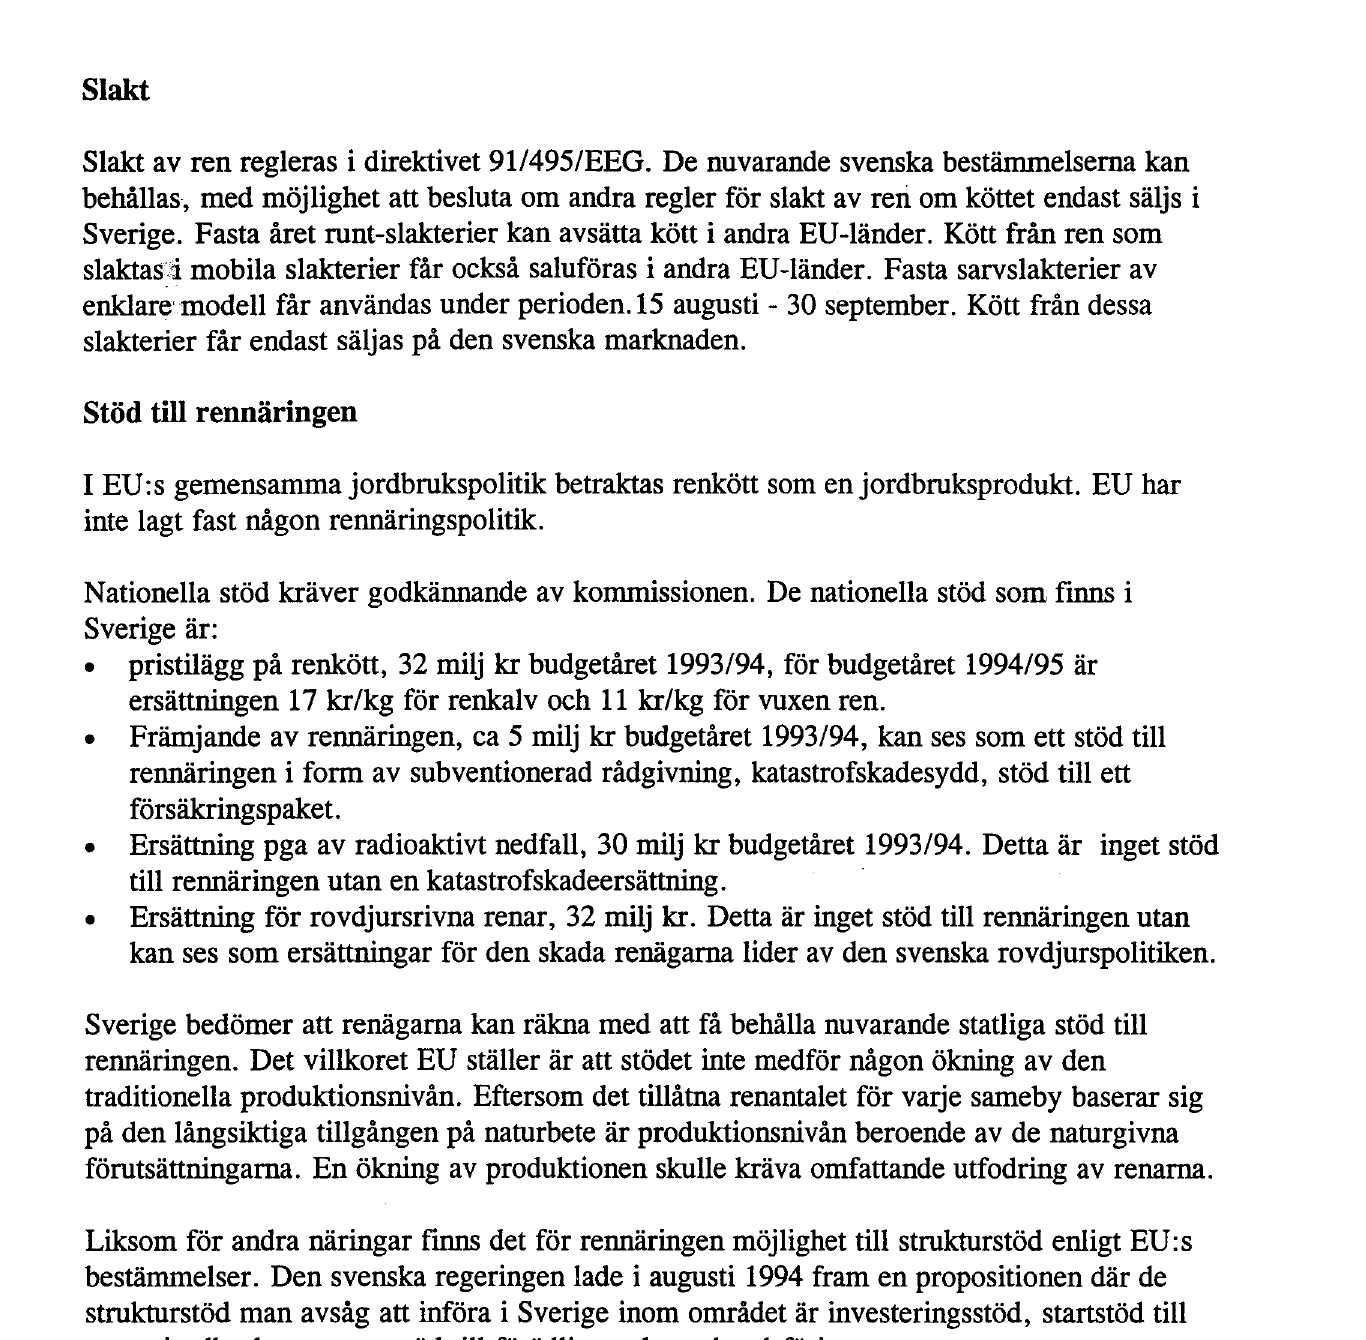
enklare modell får anvåndas under perioden. 15 augusti - 30 september. Kott från dessa slakterier får endast såljas på den svenska